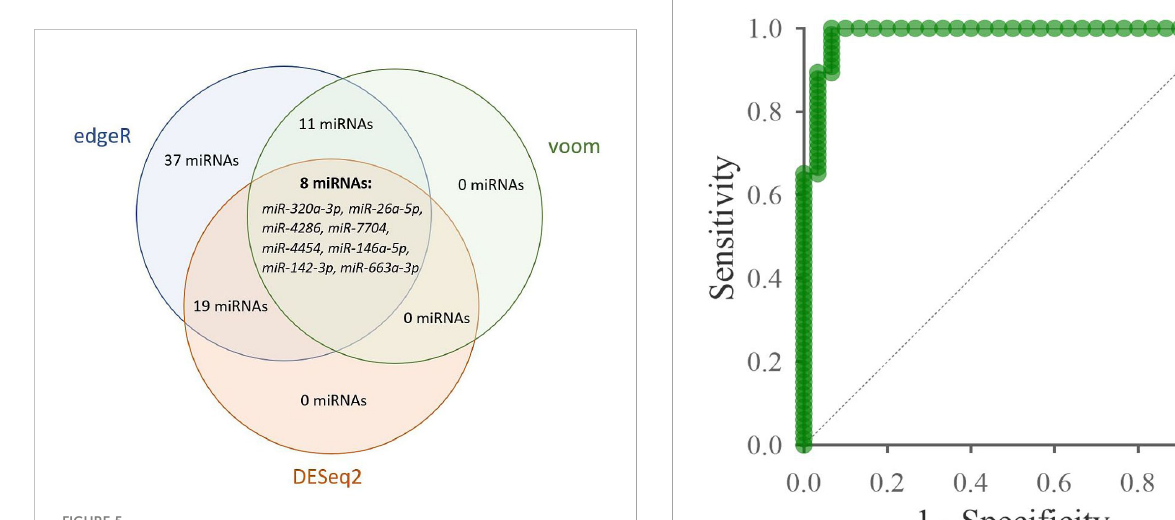
FIGURE 7 ROC curve of the proposed panel: miR-320a-3p, miR-26a-5p, miR- 7704. The x-axis shows the 1-speci fi city value, and the y-axis shows the sensitivity. The speci fi city of the proposed panel is 93.33%, and the sensitivity is 96.97%. The area under the ROC curve is 0.985. The dashed line indicates the area under the curve equal to 0.5.